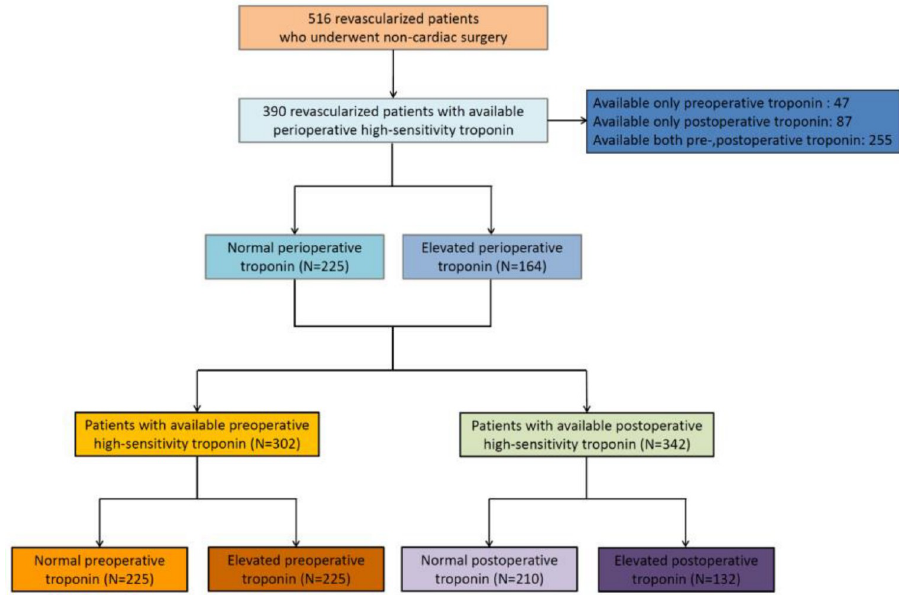
Fig 1. Flow chart of this